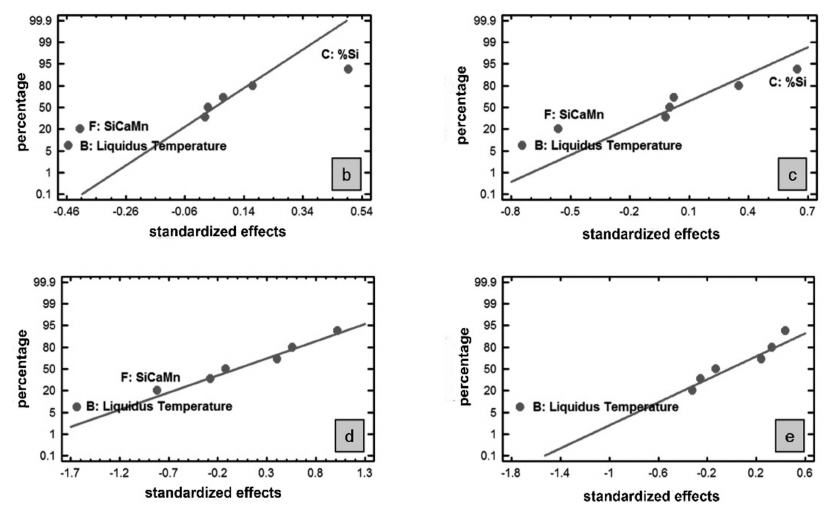
Figure 5. ( a – e ) Normal Probability Plot for the Feret diameter ratio (F max /F min ) in: ( a ) the Layer Average; ( b ) the periphery of the layer (zone I); ( c ) zone II; ( d ) zone III; and ( e ) in the layer section adjacent to the shell- interface region (zone IV).